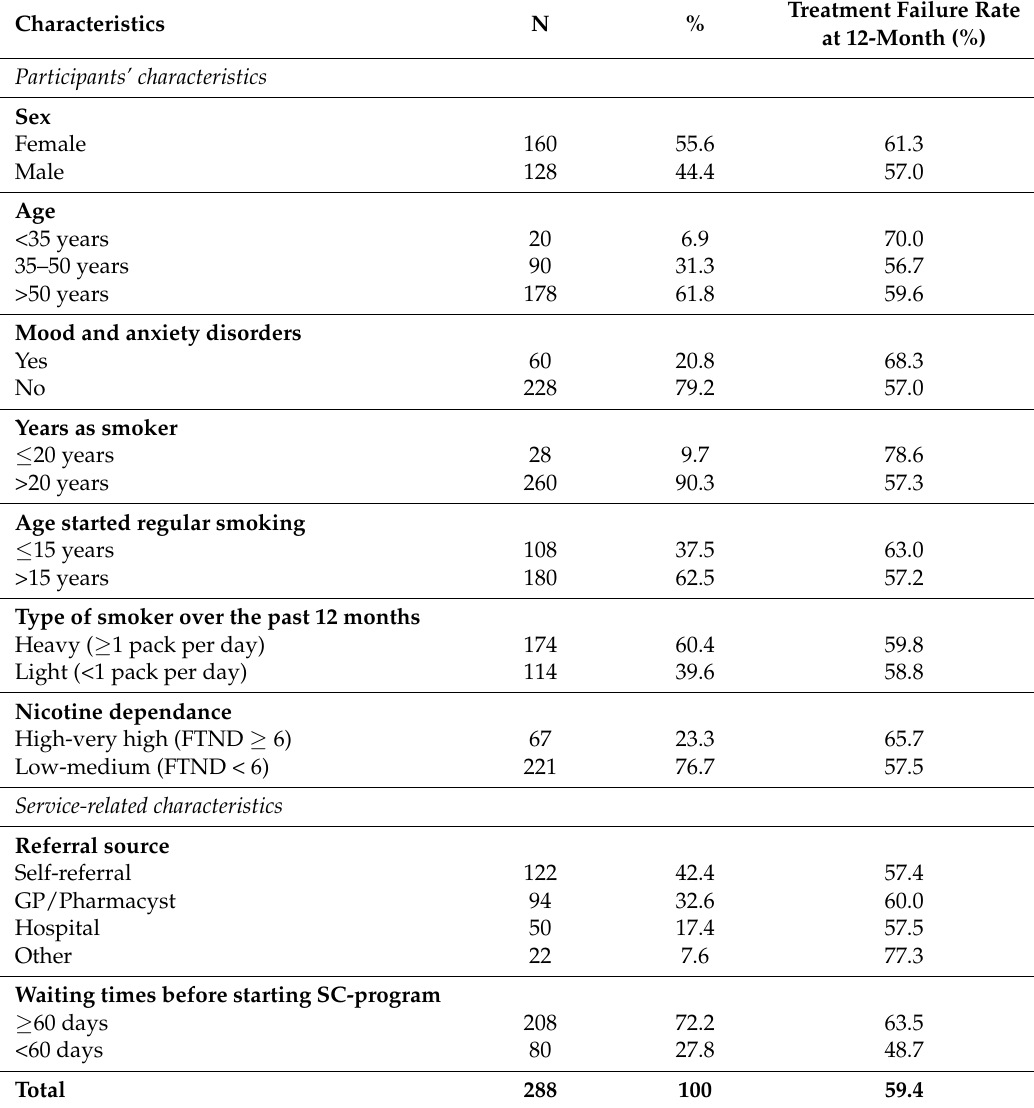
Abbreviation: FTND = Fagerstrom test for nicotine dependence; GP = general